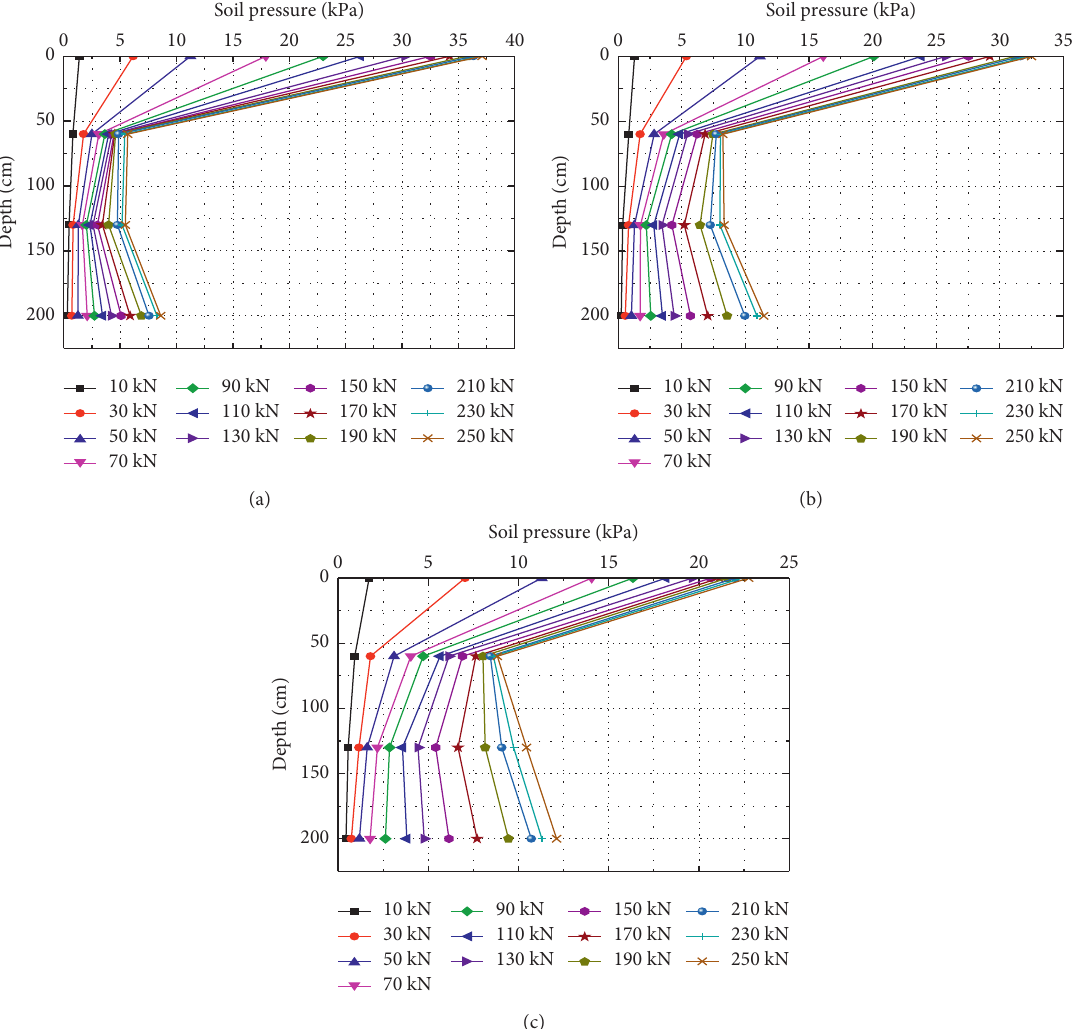
Figure 5: The soil stresses between the piles at different buried depths of the LCPF. (a–c) Different positions of SPTas shown in Figure